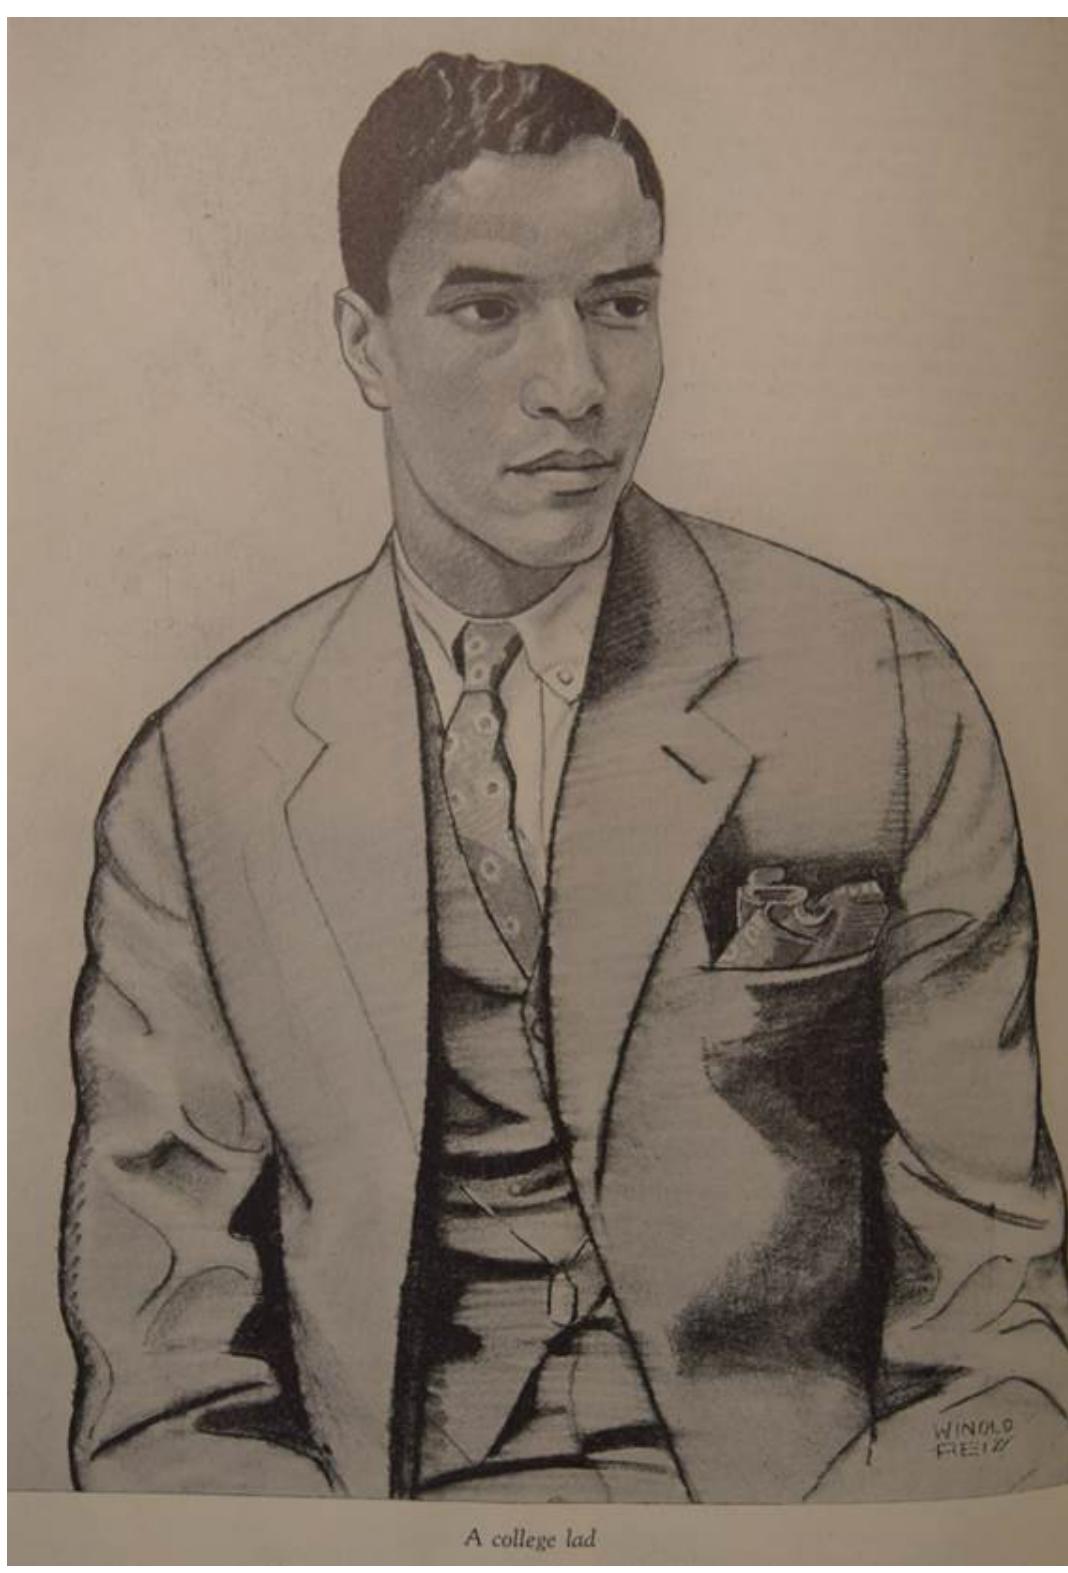
Winold Reiss, ‘A college lad’, Survey Graphic 6, No. 6 (March 1925), 654 (Courtesy: London School of Economics